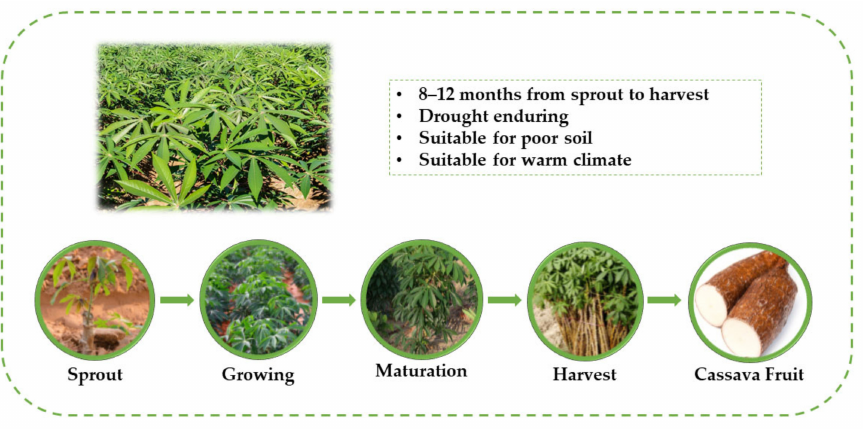
Figure 1. The field of